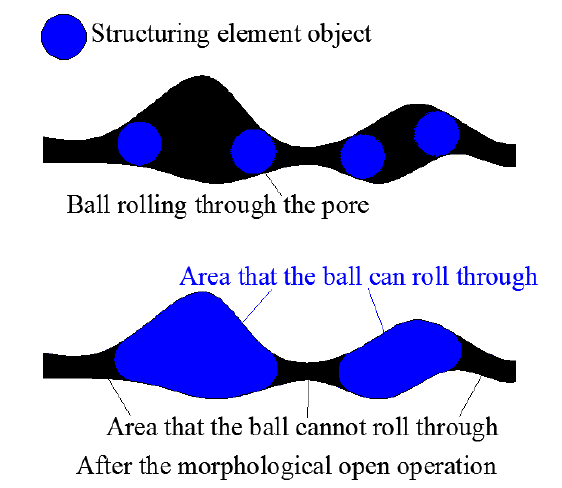
Figure 19. Physical meaning of open